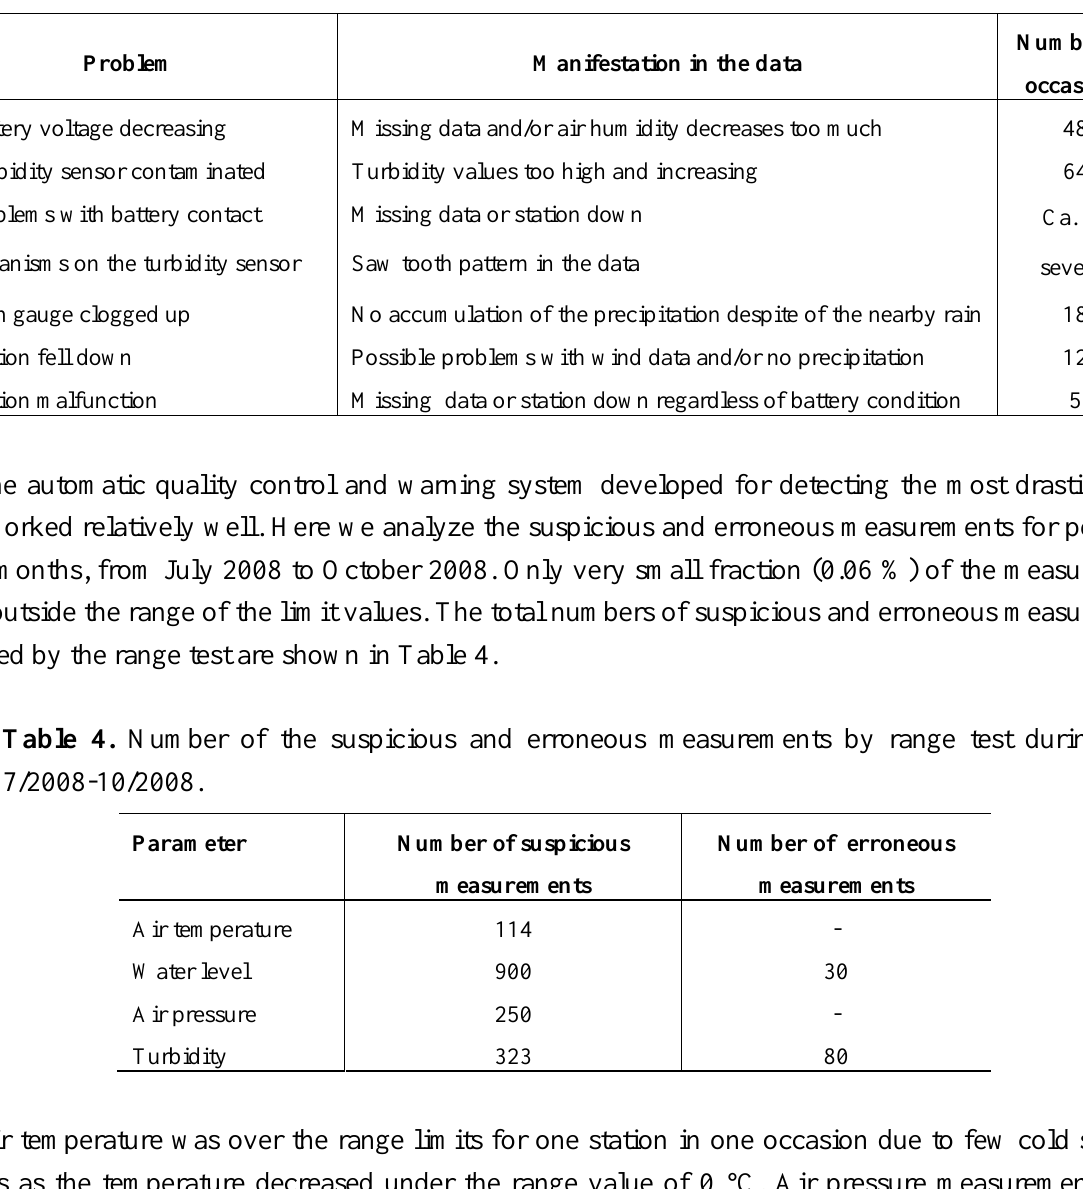
Table 3. Maintenance intensity of SoilWeather WSN during 6/2007-12/2008.